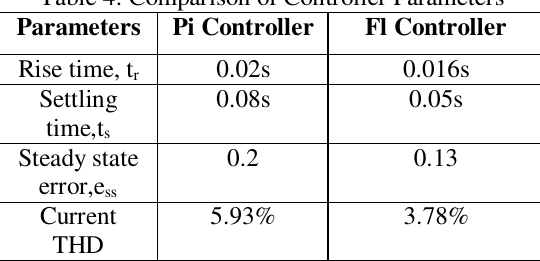
Table 4: Comparison of Controller Parameters